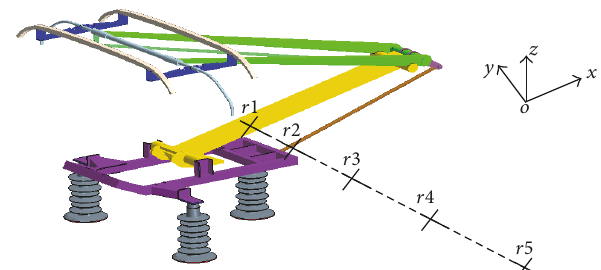
Figure 12: Distribution of observed points of aerodynamic noises in the